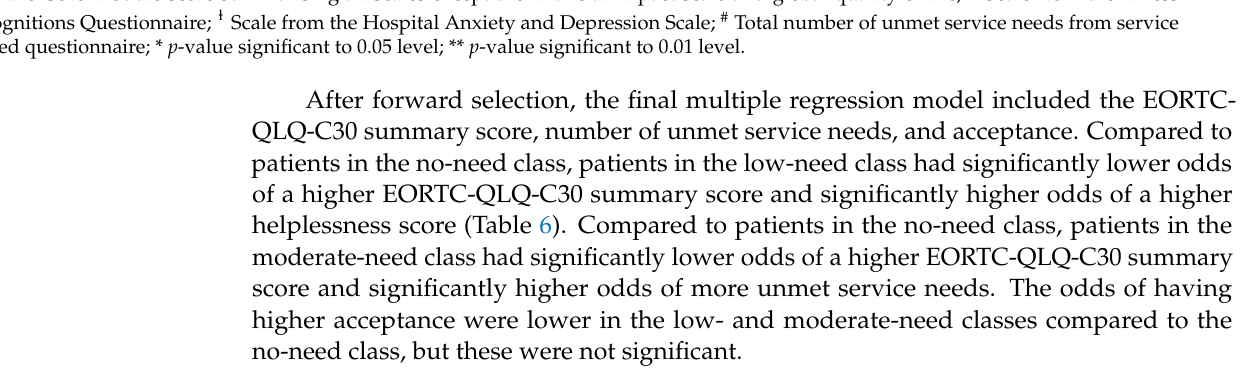
Table 6. Final multivariable regression showing covariate relationships with level of supportive care need.